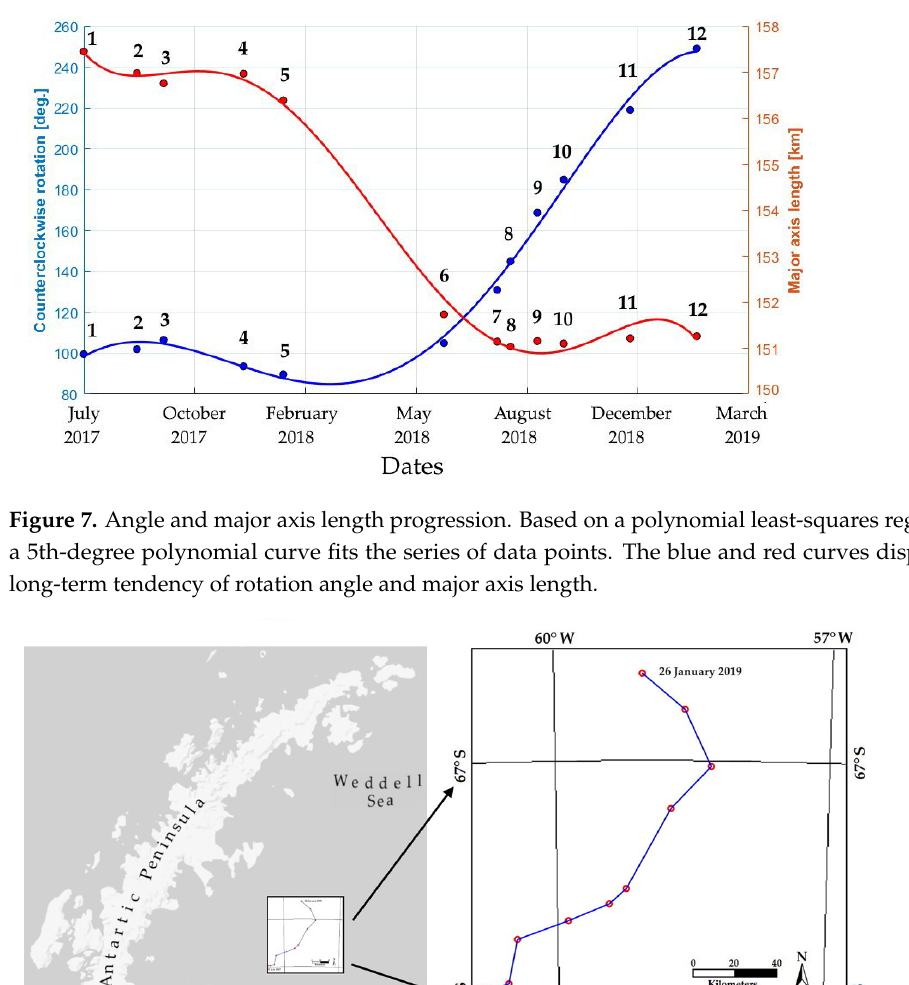
Figure 6. The derived rotation angle of the A-68A iceberg: ( a ) Image of 22 July 2017, the initial angle was 99.6 ◦ ; ( b ) Image of 26 January 2019, the angle was 249 ◦ .